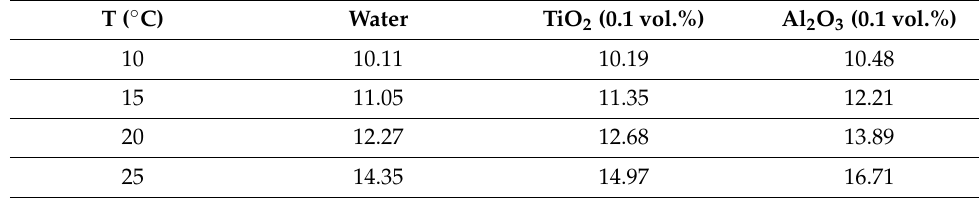
Table 8. Quantitative data of Nusselt number for different